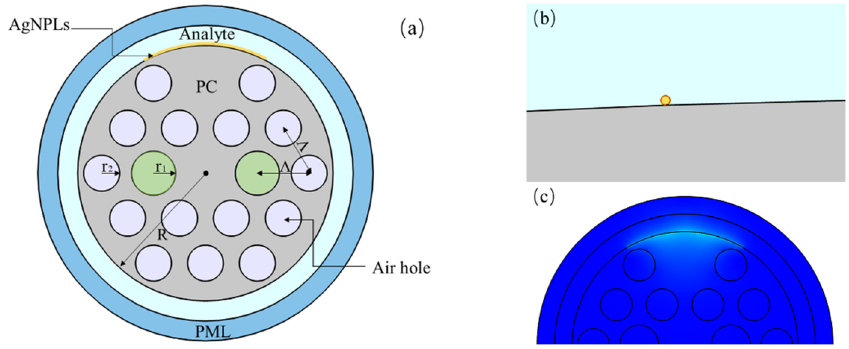
Figure 1. ( a ) The cross-section of PCF, ( b ) the schematic diagram of AgNPLs, ( c ) SPP mode.